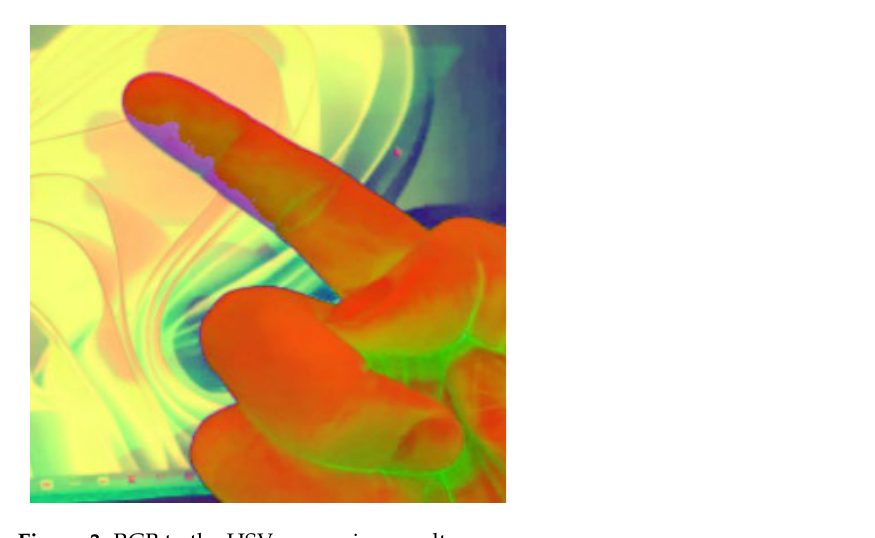
Figure 3. RGB to the HSV processing results .